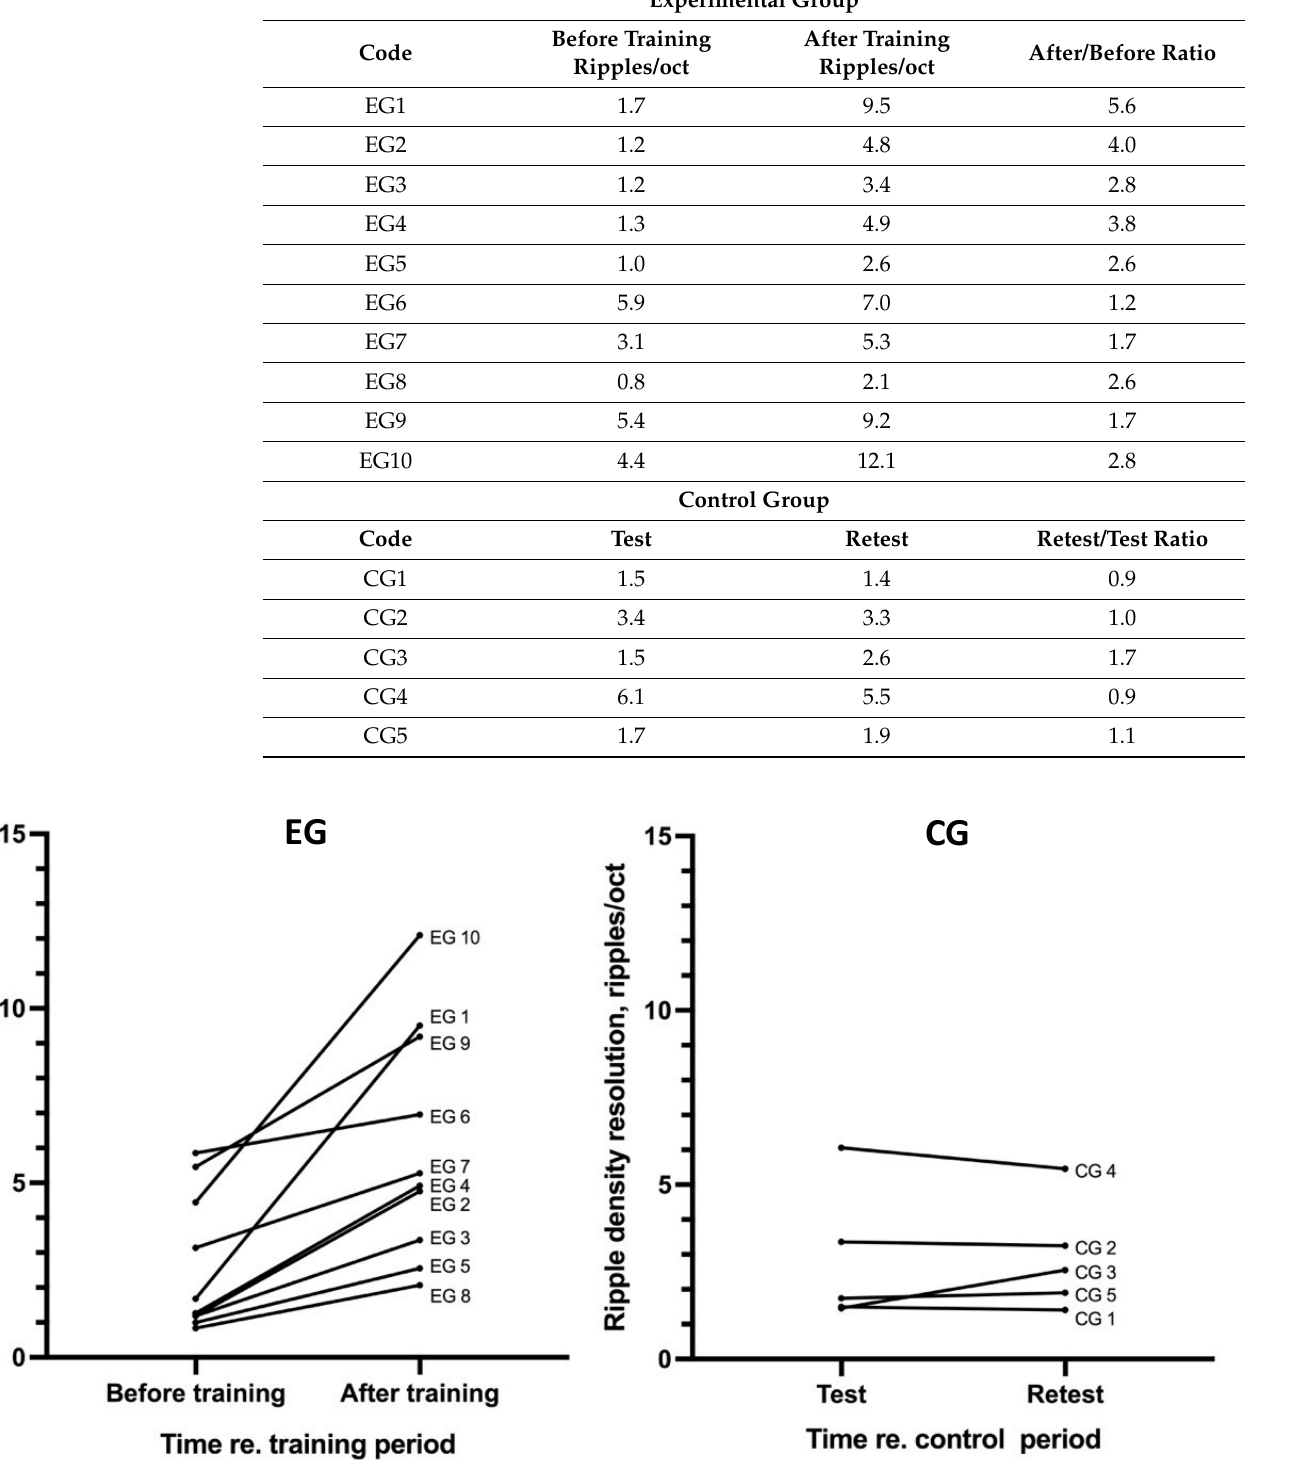
Table 2. Ripple density resolution data.